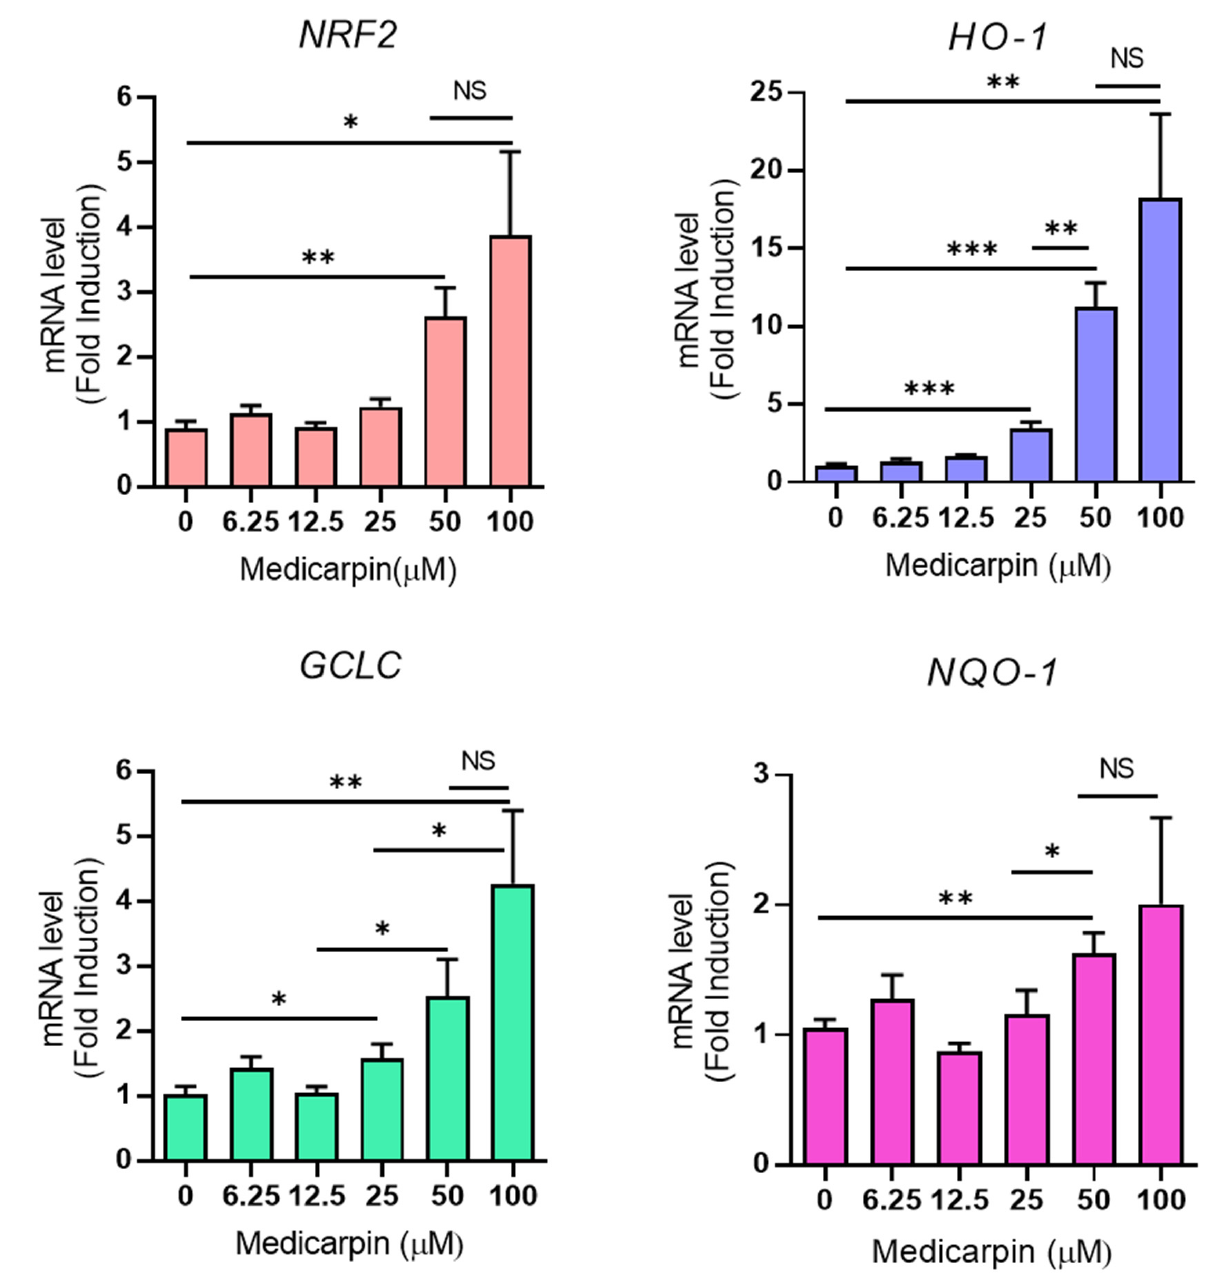
Figure 3. Medicarpin induces the transcriptional level of NRF2 and NRF2 target genes in HeLa cells. A. Real-time PCR analysis showed the mRNA levels of NRF2, HO-1, GCLC, and NQO-1 after treatment with different concentrations of medicarpin for 24 h in HeLa cells. Experiments were performed in triplicate. * p < 0.05; ** p < 0.001; *** p < 0.0001; NS, not significant.